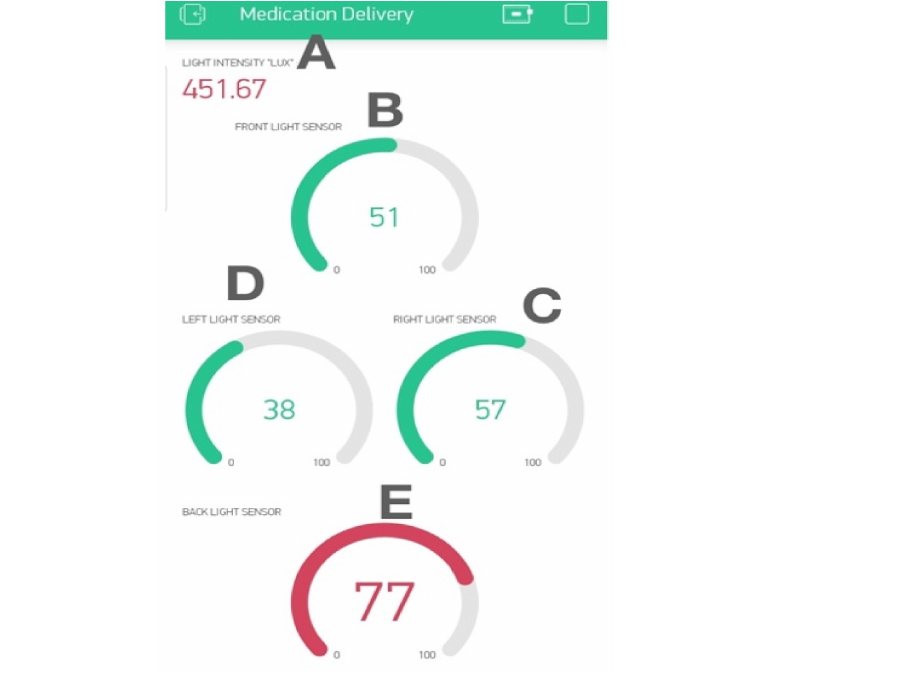
Figure 13. IoT mobile app of Guidance Landing System (GLS). ( A ) The upper numerical value shows the light intensity the backside. ( B ) The light intensity percentage of the front-side sensor. ( C ) Light intensity percentage of the right-side sensor. ( D ) Light intensity percentage of the left-side sensor. ( E ) Light intensity percentage of the back-side sensor.